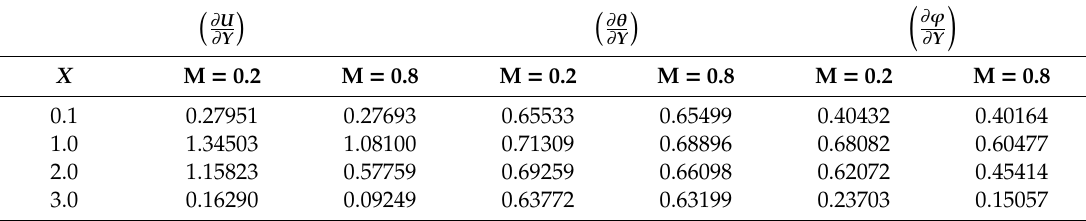
Table 2. Physical e ff ects on quantities ∂ U ∂ are constant.